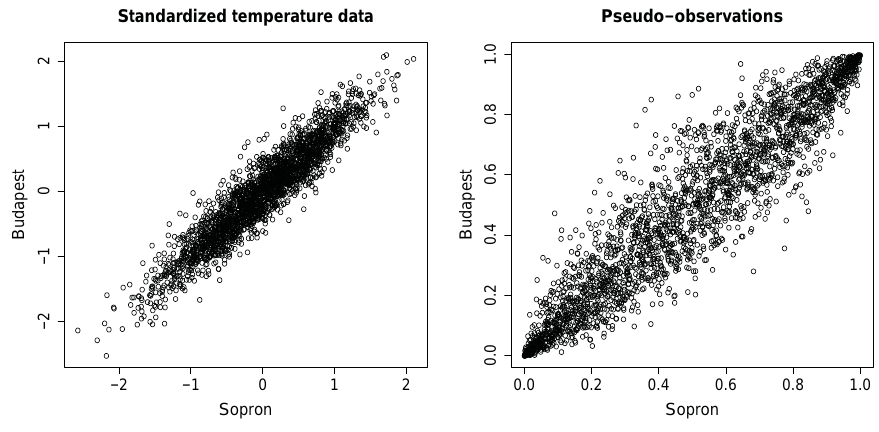
Figure 1. Bivariate data and the corresponding